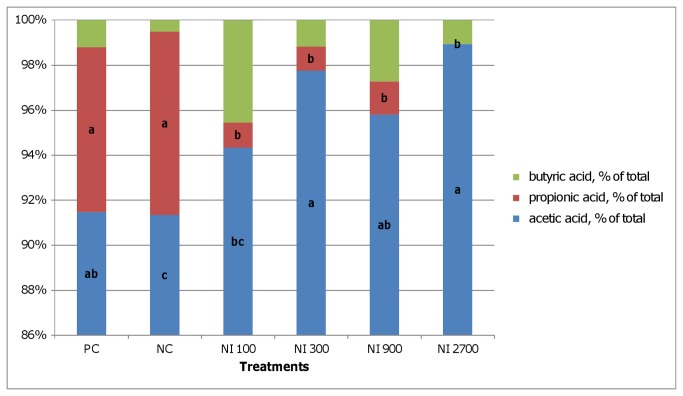
SCFA profiles in ileum digesta.PC - positive control (salinomycin, 60 mg/kg); NC- negative control (any additives); NI100 - 100 IU nisin/g (3.2 ml/kg); NI300 - 300 IU nisin/g (9.7 ml/kg); NI900 - 900 IU nisin/g (20.1 ml/kg); NI2700 - 2700 IU nisin/g (87.2 ml/kg); Different letters indicate significant differences between treatments (P≤ 0.05).